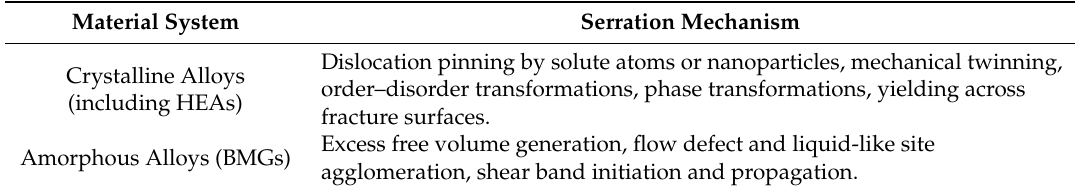
Table 1. Some of the underlying mechanisms of the serrated flow in crystalline and amorphous alloys. Material System Serration Mechanism Dislocation pinning by solute atoms or nanoparticles, mechanical twinning, Crystalline Alloys order–disorder transformations, phase transformations, yielding across (including HEAs) fracture surfaces. Excess free volume generation, flow defect and liquid-like site Amorphous Alloys (BMGs) agglomeration, shear band initiation and